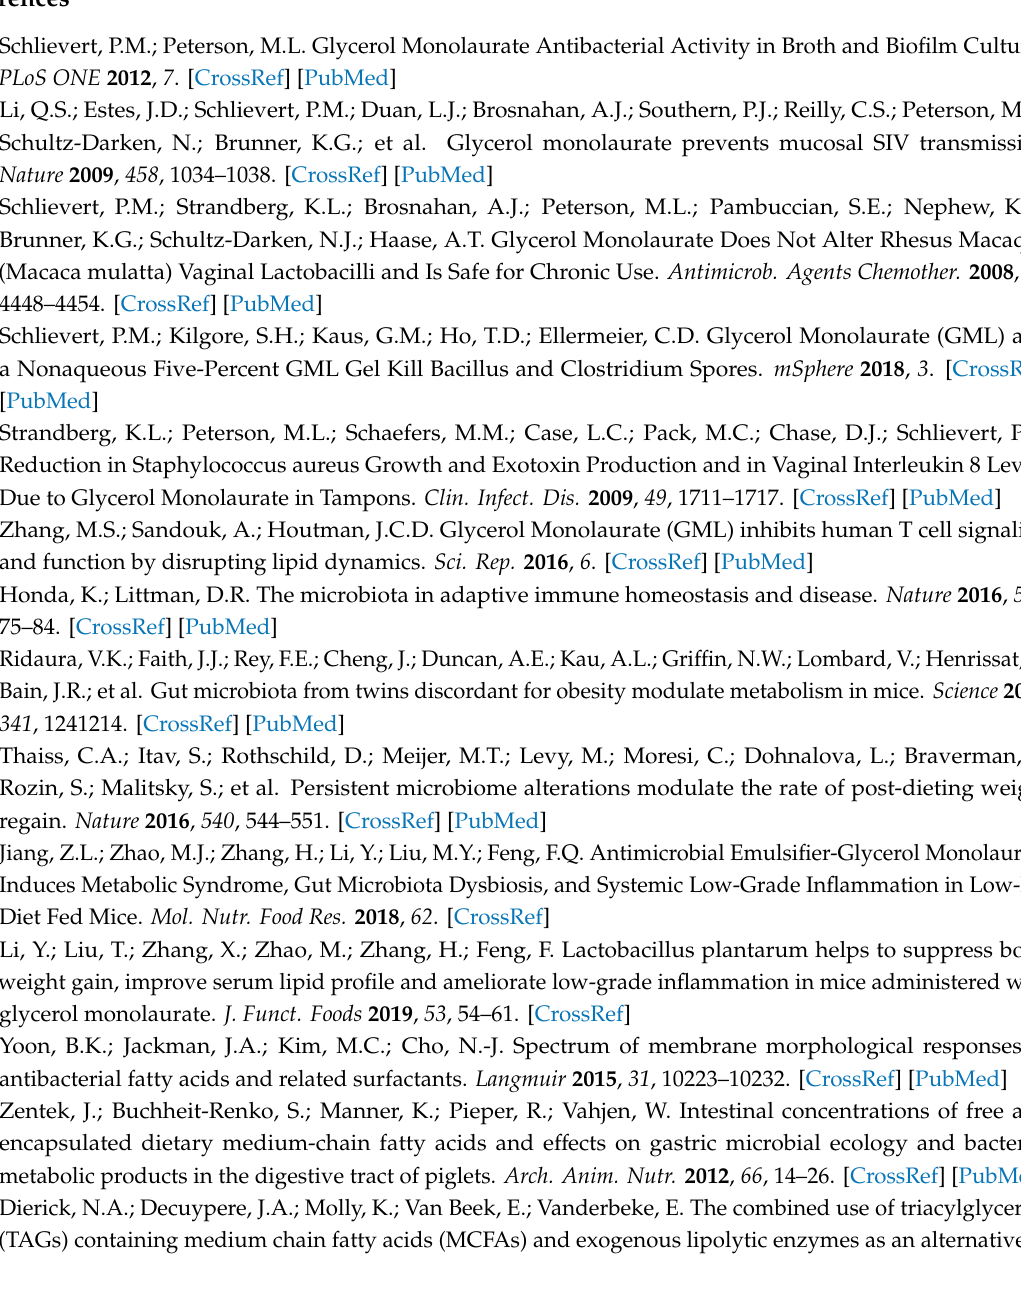
Figure S1: H&E staining of the (A) duodenum and (B) colon section from mice treated with di ff erent doses of GML to study inflammation of the intestine ( n = 6), Table S1: Primer sequences used in qRT-PCR